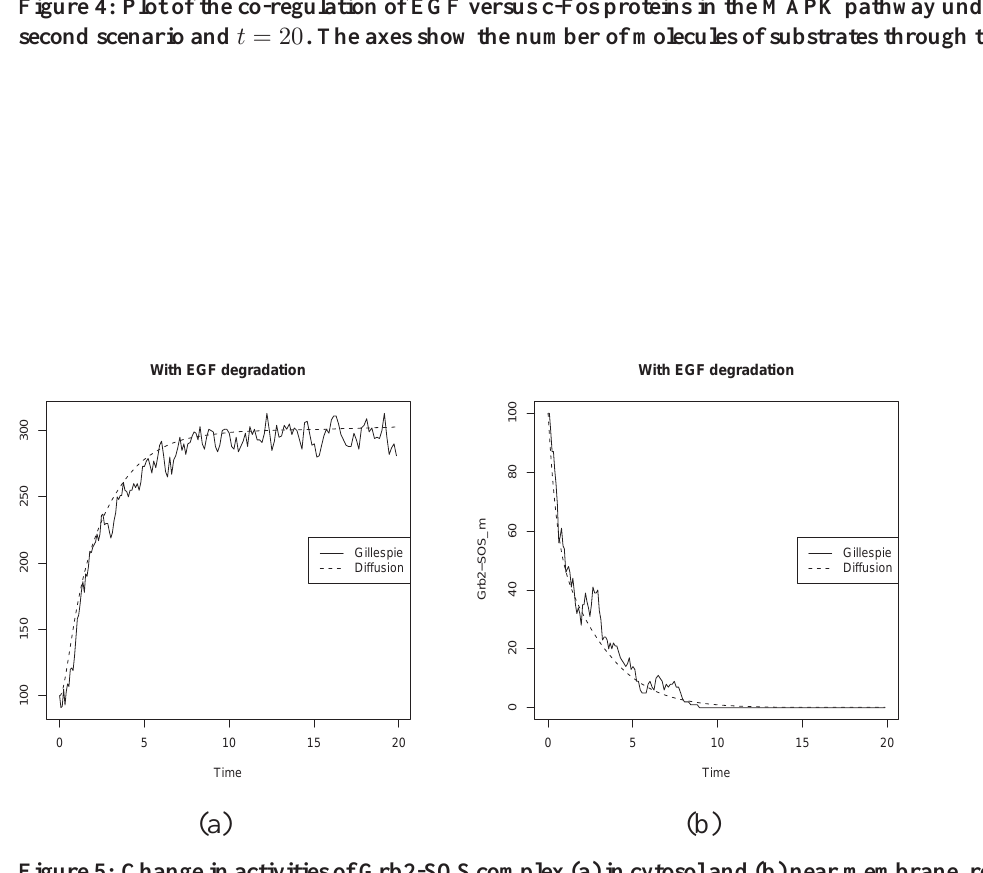
Figure 5: Change in activities of Grb2-SOS complex (a) in cytosol and (b) near membrane, respec- tively including the degradation of EGF by using both Gillespie algorithm and diffusion approx- imation under the second scenario and t = 20 . The y -axes illustrate the number of molecules of the Grb2-SOS complexes for the time t